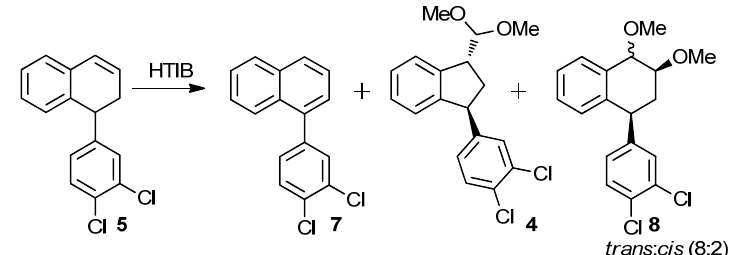
Table 1. Oxidation of 1,2-dihydronaphthalene 5 with HTIB in